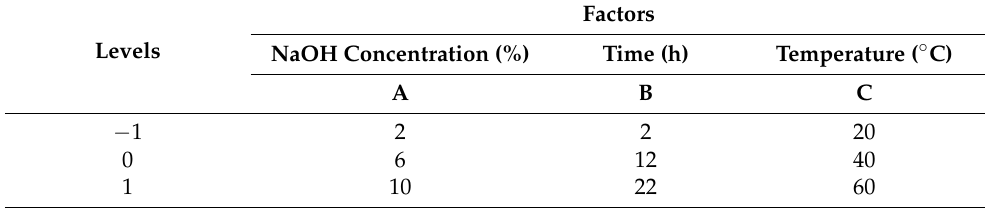
Table 1. Factors and levels of